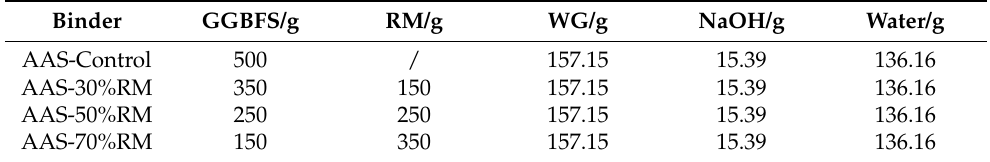
Table 2. AASR pastes mixture proportions (per